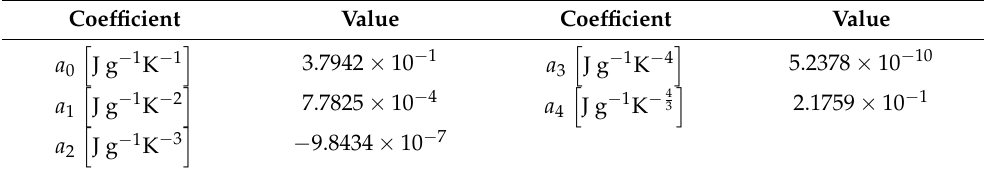
Table 3. Coefficients for calculating specific heat capacity of X37CrMoV5-1 samples in Equation (4).